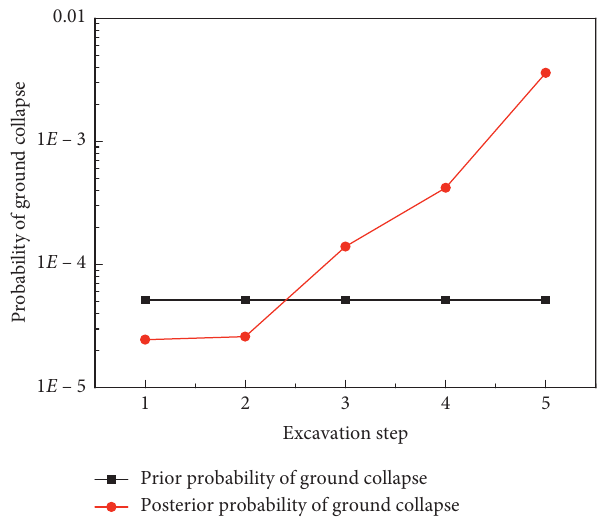
Figure 10: Comparison of prior and posterior probabilities of ground collapse induced by shield